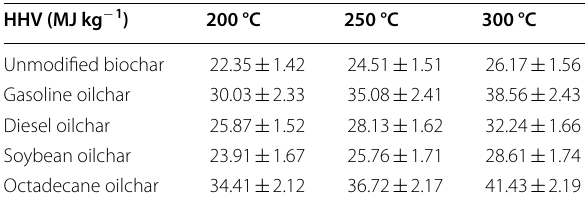
Table 4 Calorific value (HHV) of microalgal biochar and oilchar